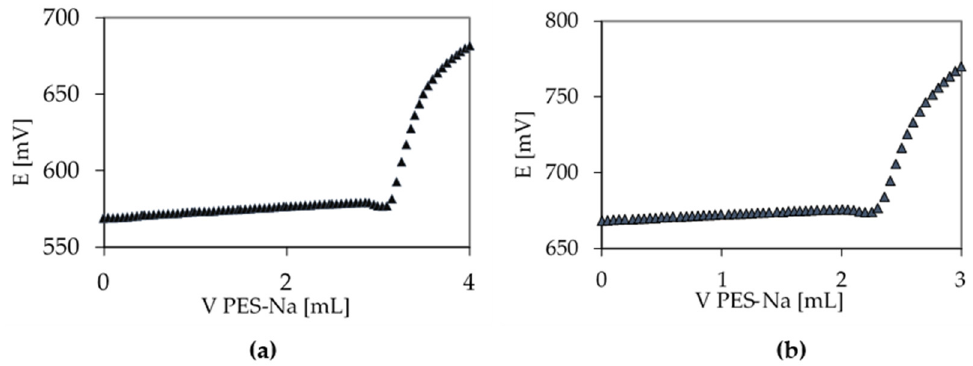
Figure 3. Polyelectrolyte titration curves of: PE-2%CS + CSNPs ( a ) and PP-2%CS + CSNPs ( b ).